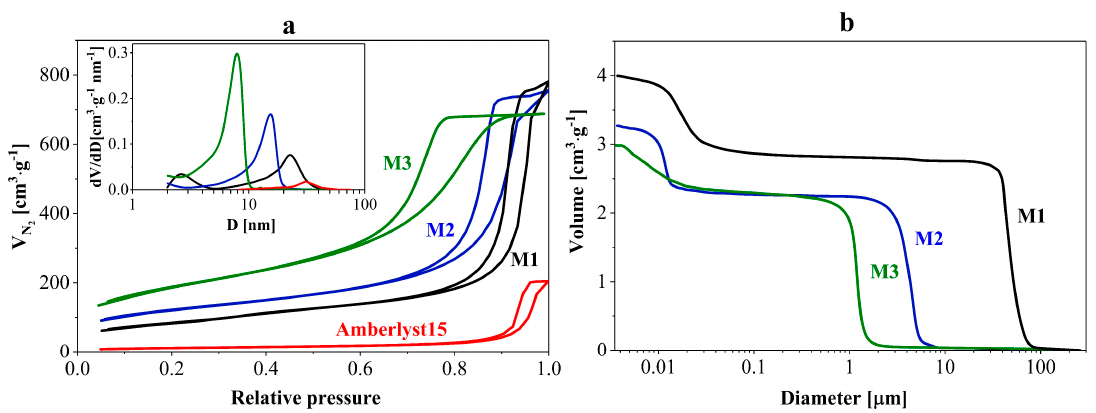
Figure 2. ( a ) N 2 adsorption/desorption isotherms and pore size distribution in monoliths and Amberlyst 15; ( b ) Cumulative pore volume curves determined by mercury porosimetry. Table 1. Structural and acidic properties of the materials.